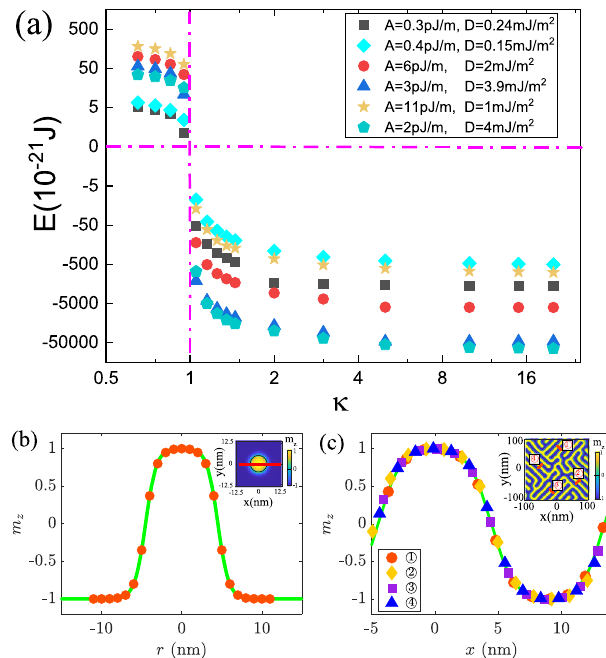
Fig. 1 Con fi rmation of demagnetization approximation. a Structure of a rami fi ed skyrmion. b Energies of 90,000 cells from spin texture shown in sub- fi gure ( a ). Cells are sorted by z -component of magnetization m